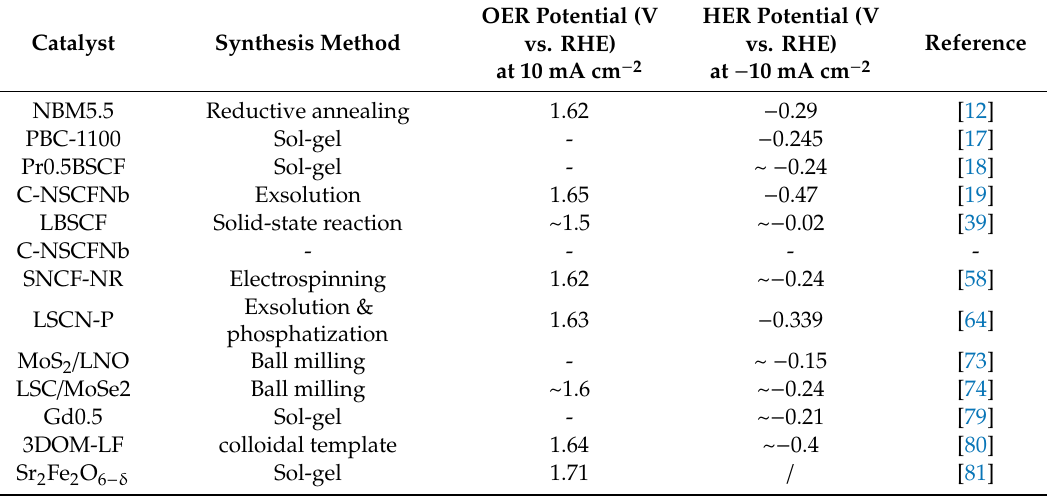
Table 1. OER (oxygen evolution reaction) and HER (hydrogen evolution reaction) activities of recently reported perovskite catalysts observed in an alkaline